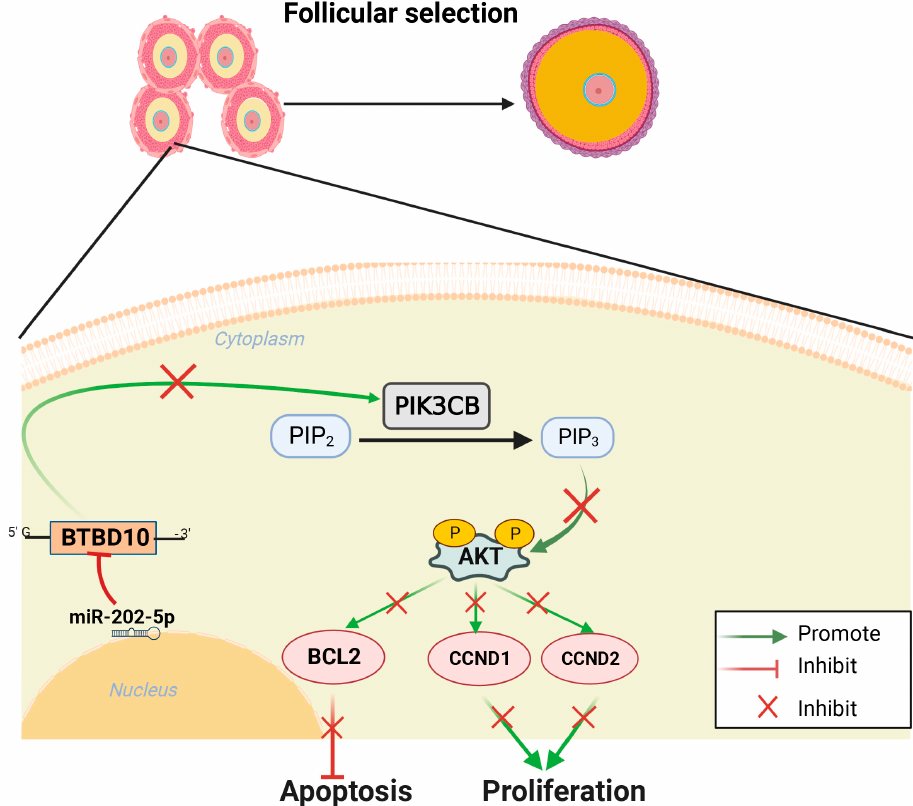
Figure 10. Molecular mechanism prediction of miR-202-5p regulating proliferation and apoptosis of GCs during the geese follicular selection. Supplementary Materials: The following supporting information can be downloaded at: www.mdpi.com/xxx/s1. Author Contributions: Conceptualization, J.W., M.R., and S.H.; methodology, J.W., M.R., and S.H.; formal analysis, M.R. and Q.O.; investigation, M.R., H.X., X.Z., Y.L., J.H., and H.H.; writing—origi-